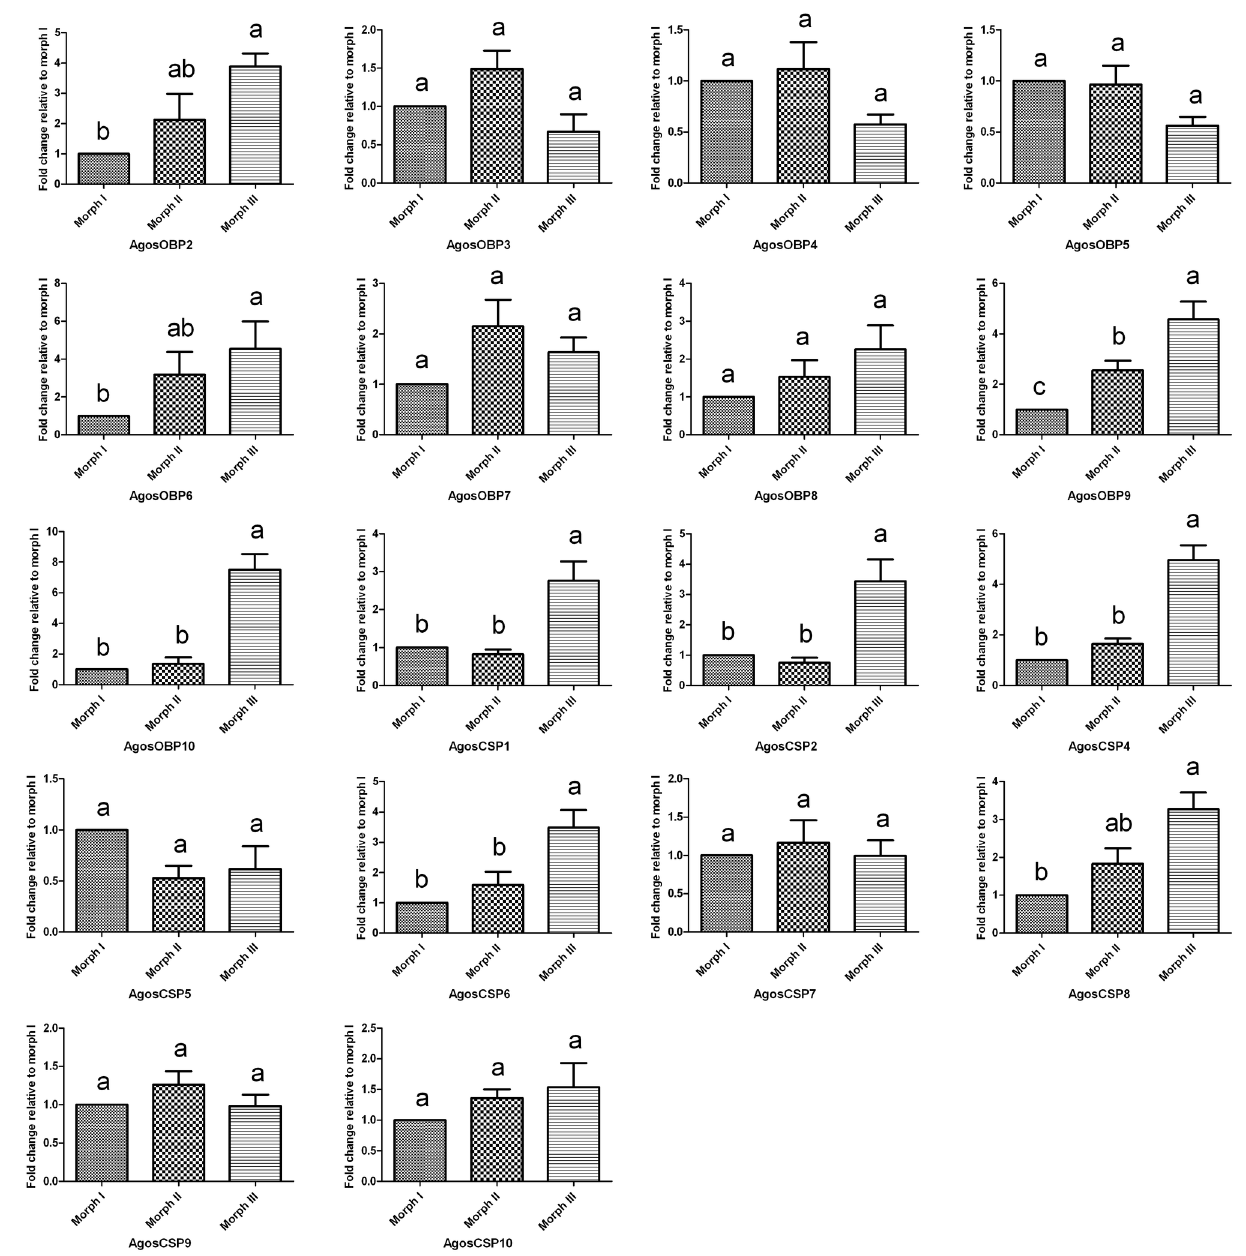
Figure 8. Stage-specific expression profiles of A . gossypii OBPs and CSPs as measured by qRT-PCR . The fold changes are relative to the transcript levels in the Morph I. The standard error is represented by the error bar, and the letter above each bar indicates the statistical differences; the bars with different letters (a, b, c) indicate significant differences ( p <0.05) and with same letters indicate no differences between mean expression